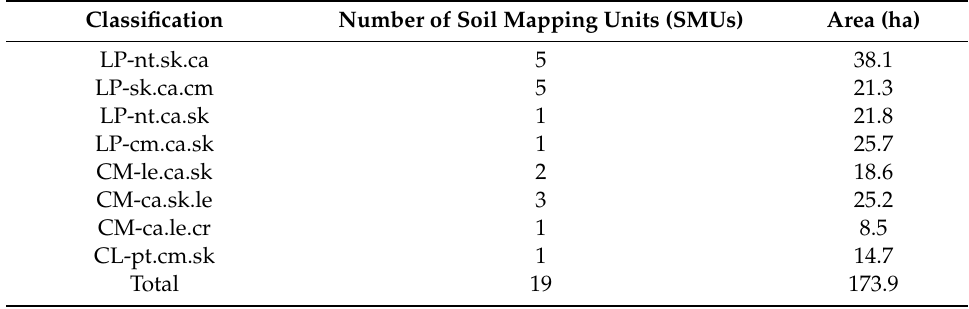
Table 2. Grouping of soils according to the World Reference Base for Soil Resources (WRB) taxonomical system to the level of third Principal